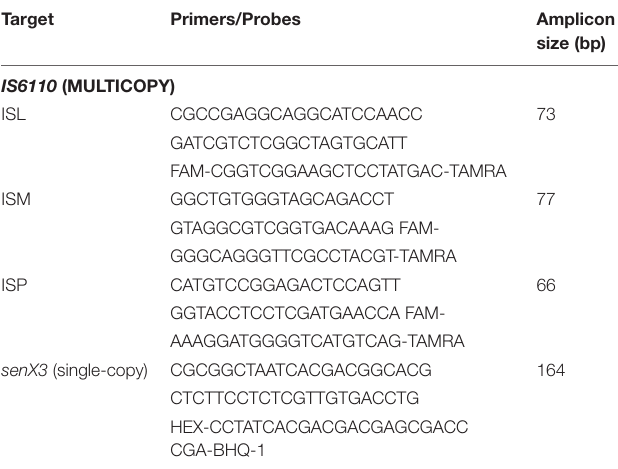
TABLE 1 | Primer-probe sets used in this